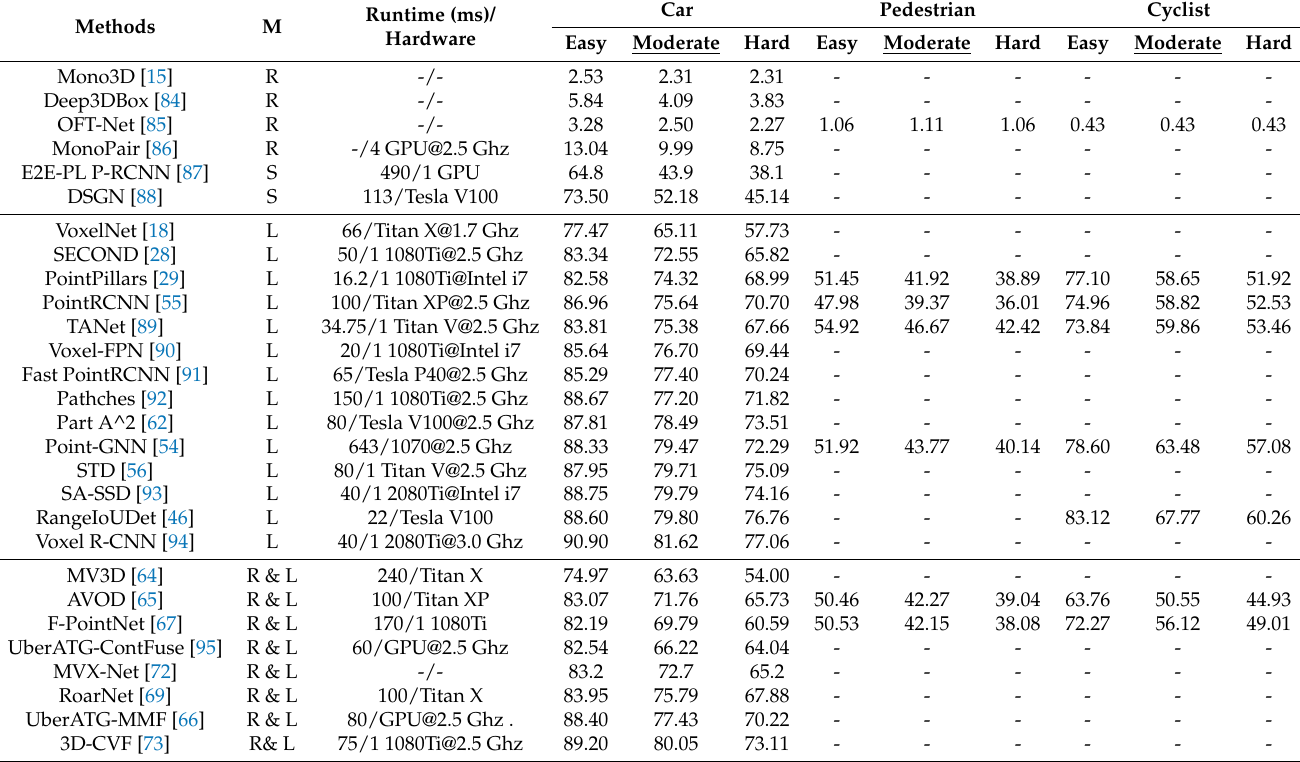
Table 2. Performance comparison of 3D object detection on KITTI test set (Average precision in %). Methods